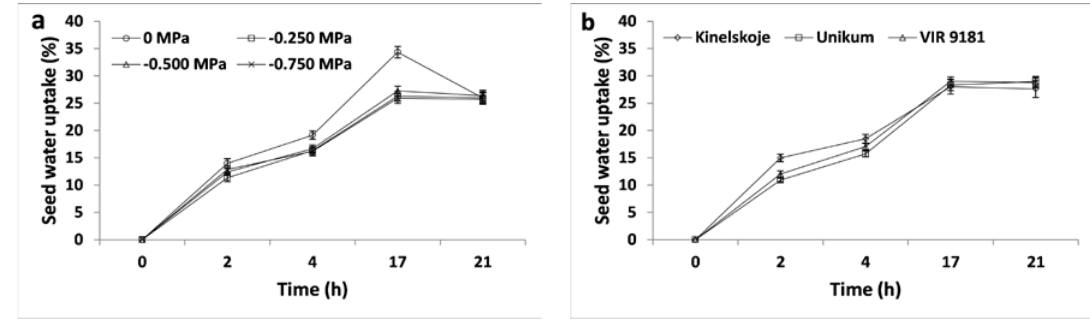
Figure 2. Time course of water uptake as affected by ( a ) osmotic pressure and ( b ) millet genotypes.